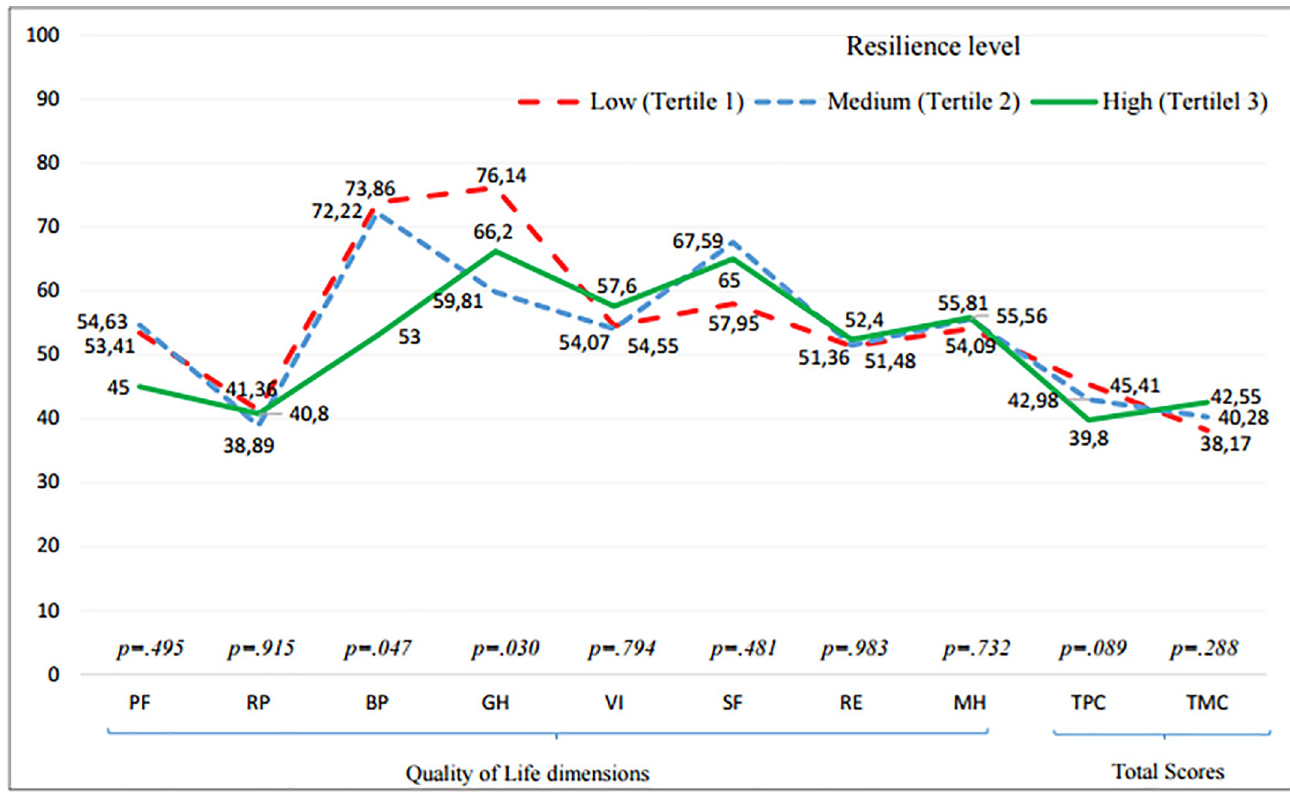
Fig 2. Comparison of means of quality of life by resilience tertiles. PF-Physical Functioning, RP-Physical Role Limitations, BP-Body pain, GH-General Health, VI-Vitality, SF-Social Functioning, RE-Emotional Role Limitations, MH-Mental Health, TPC-Total Physical component, TMC-Total Mental Component.